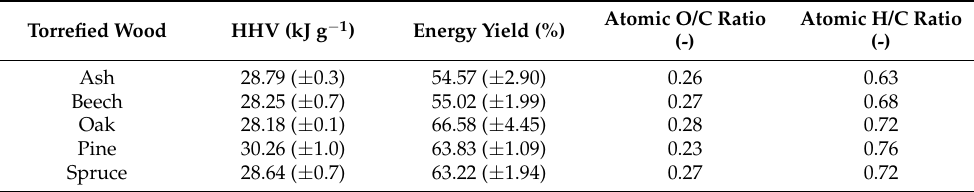
Table 3. The energy characteristics of samples of torrefied wood.